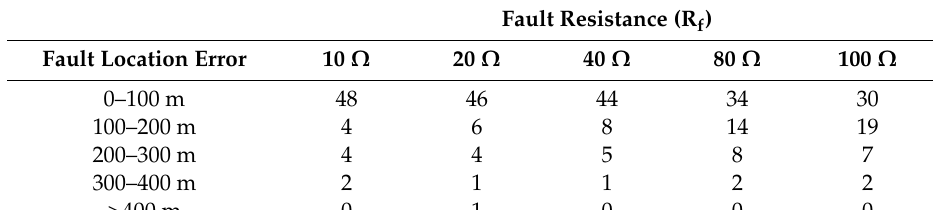
Table 3. Number of faults by class of error for di ff erent fault resistances.